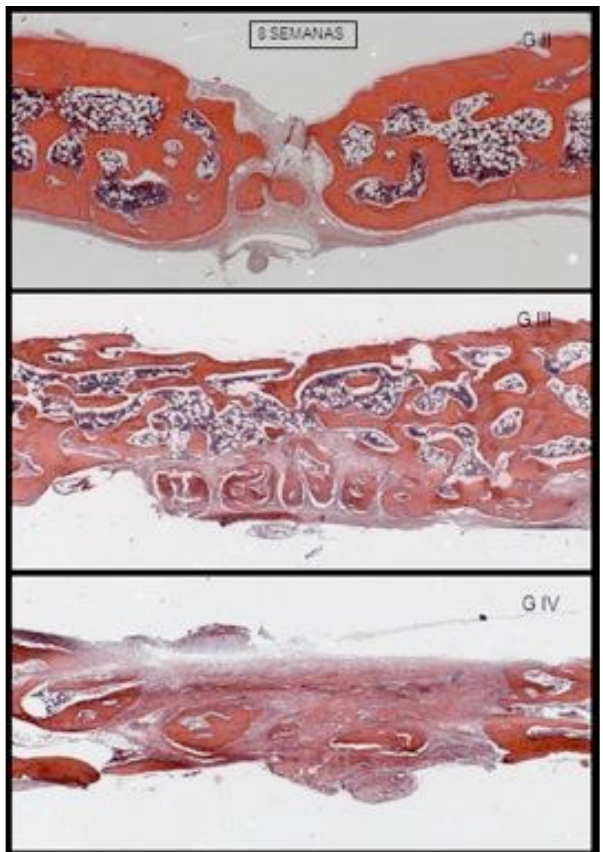
FIGURE 7 - Histological slides of the skull at M3 in Groups II, III and IV after 8 weeks